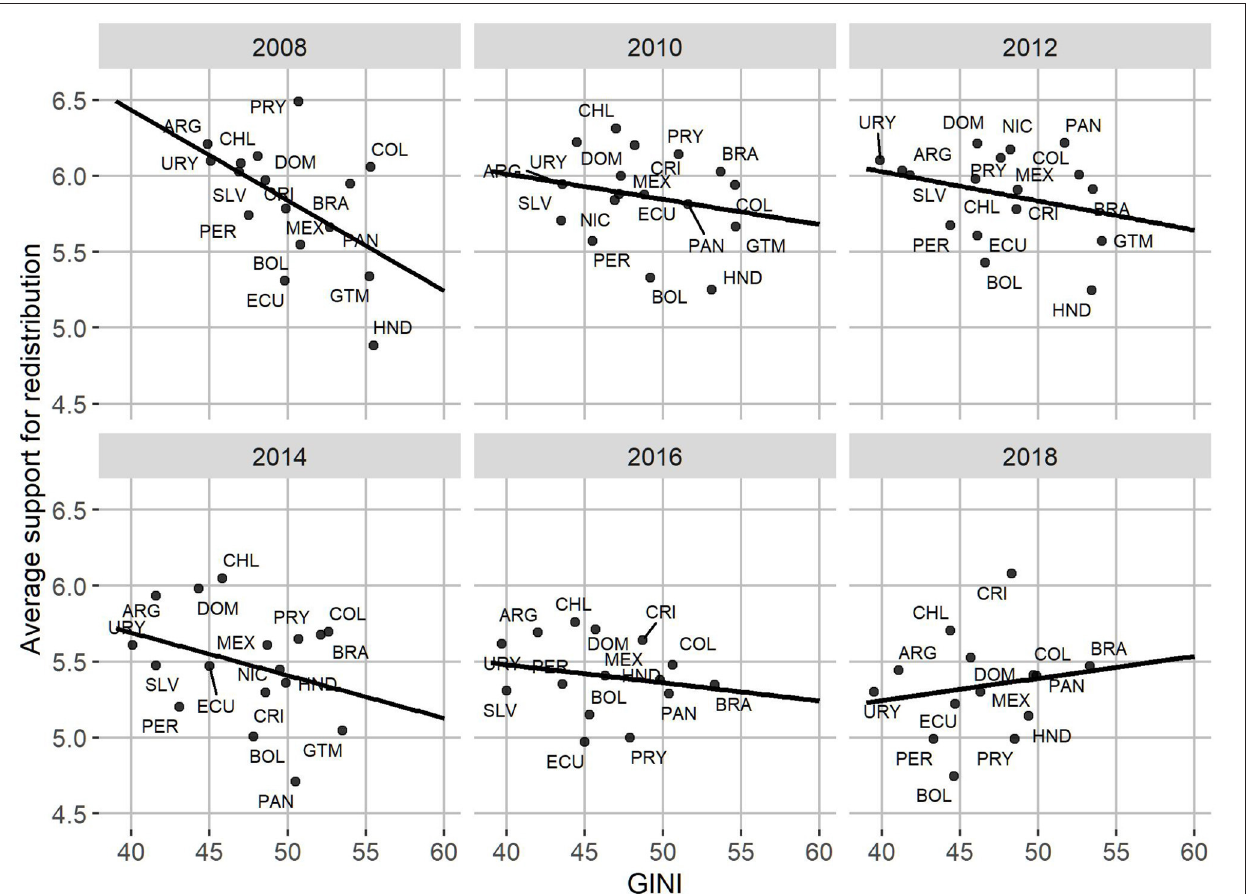
FIGURE 4 | Average support for redistribution and GINI, by country and